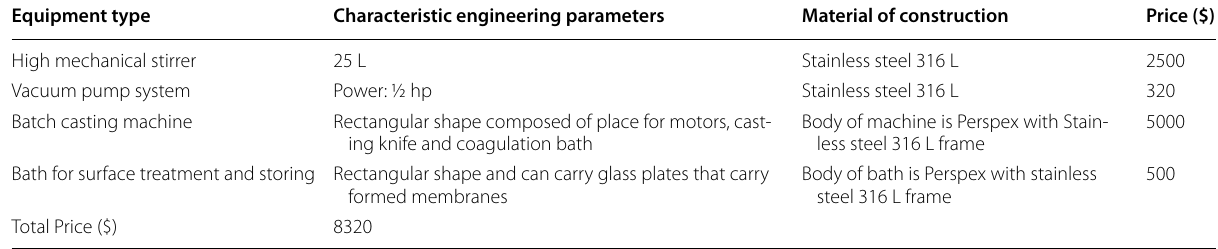
Table 4 Cost of individual items used to develop designed machines Equipment type